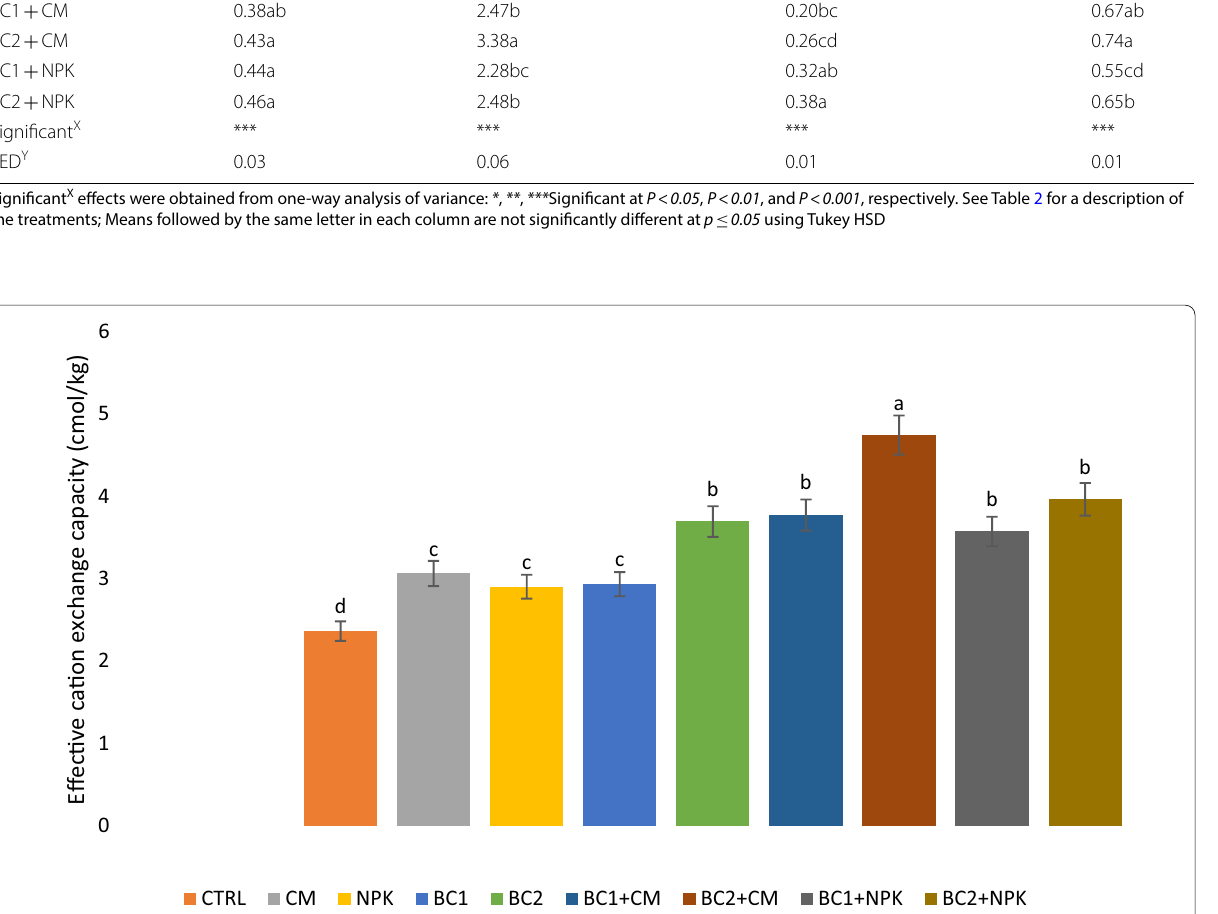
Fig. 1 Residual effect of biochar, farmyard manure compost and/NPK on the on the effective cation exchange capacity. The same letter on the bars are not significantly different at p 0.0 5 using Tukey HSD. Error bars represent standard deviation of the ≤